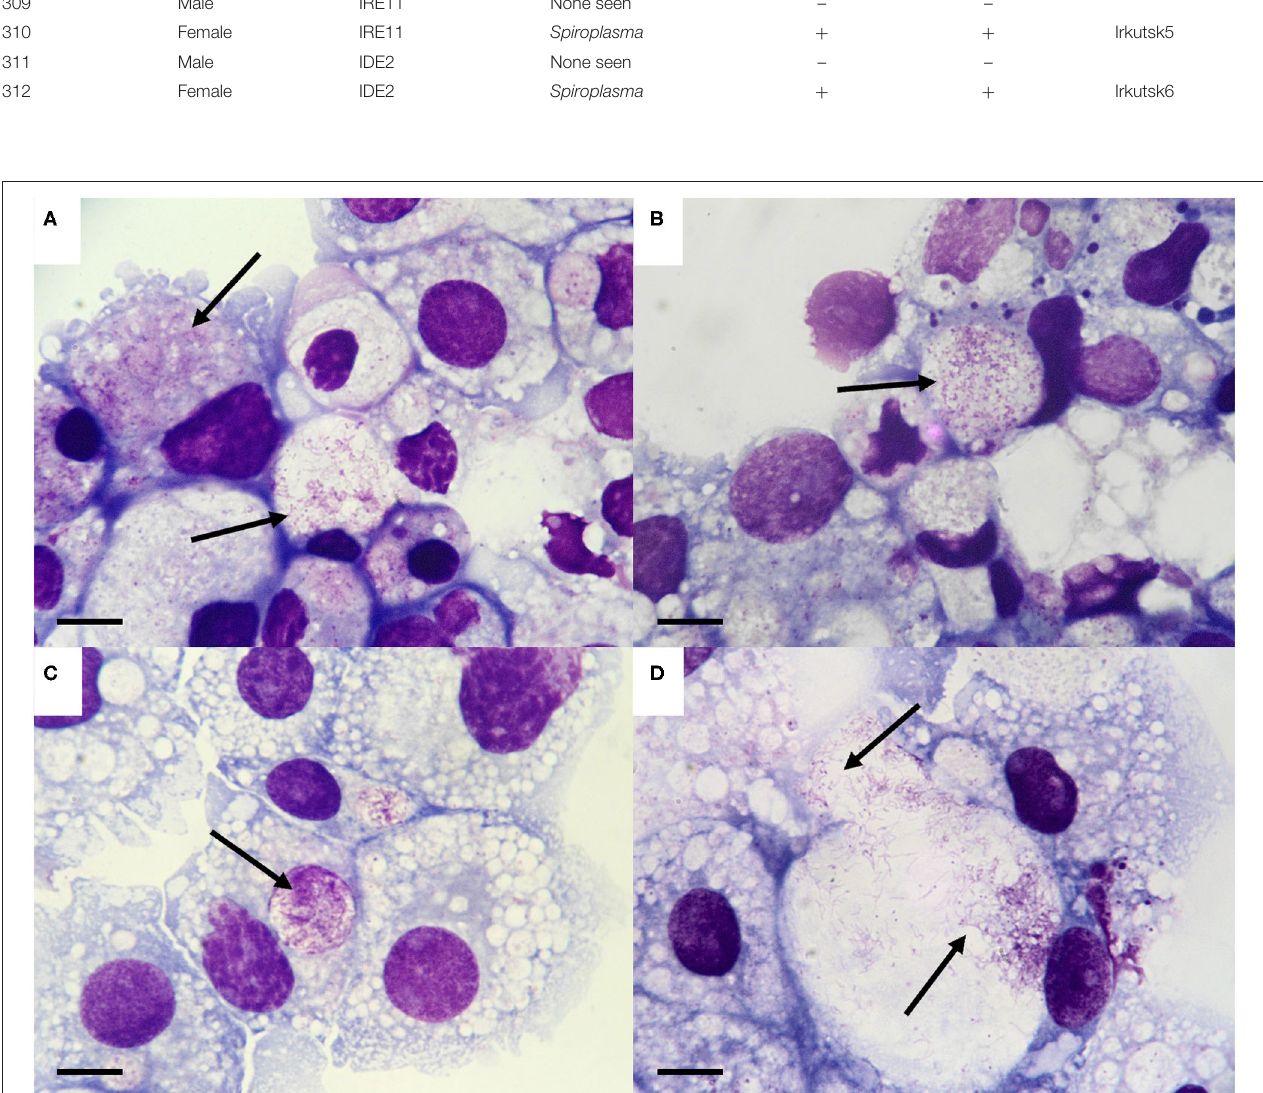
FIGURE 1 | Morphology of the Spiroplasma sp. isolated from Ixodes persulcatus ticks. (A–D). Spiroplasma (arrows) in tick cell lines inoculated with internal organs from male and female I. persulcatus ticks, day 53 post inoculation. (A) BME/CTVM23 cells inoculated with male tick #304 ( Spiroplasma strain Irkutsk1). (B) BME26 cells inoculated with female tick #308 ( Spiroplasma strain Irkutsk4). (C,D). IRE11 cells inoculated with female tick #310 ( Spiroplasma strain Irkutsk5). Giemsa-stained cytocentrifuge smears; scale bars = 10 µ m.